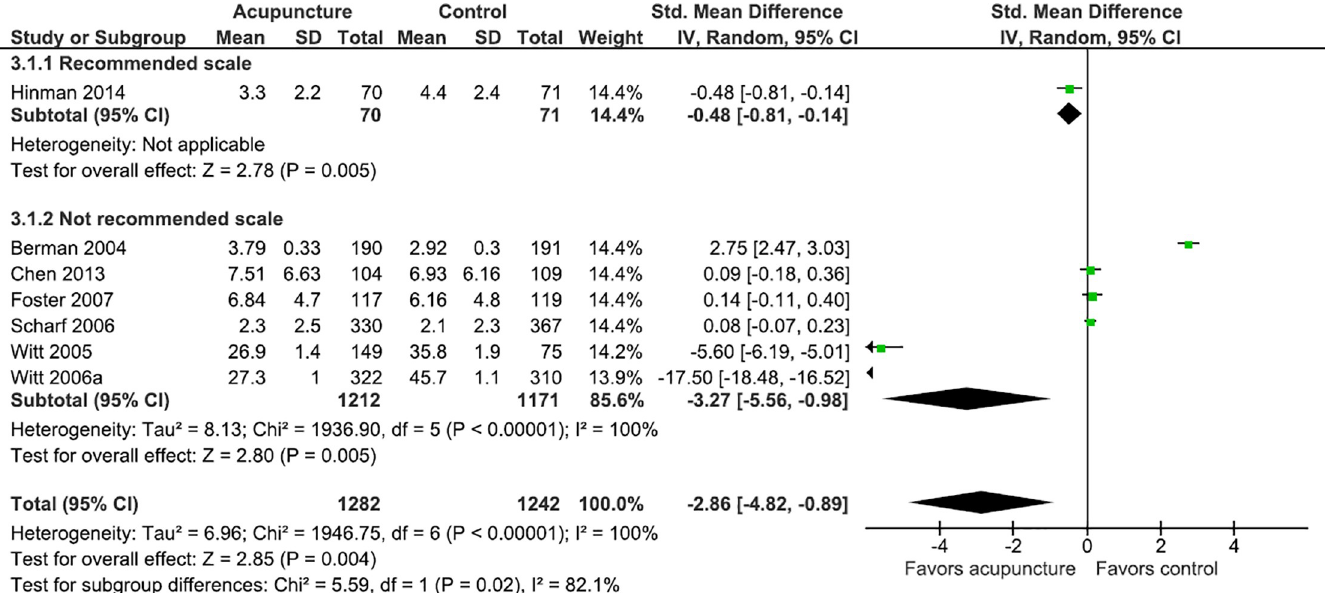
PLOS ONE | https://doi.org/10.1371/journal.pone.0231444 April 16,